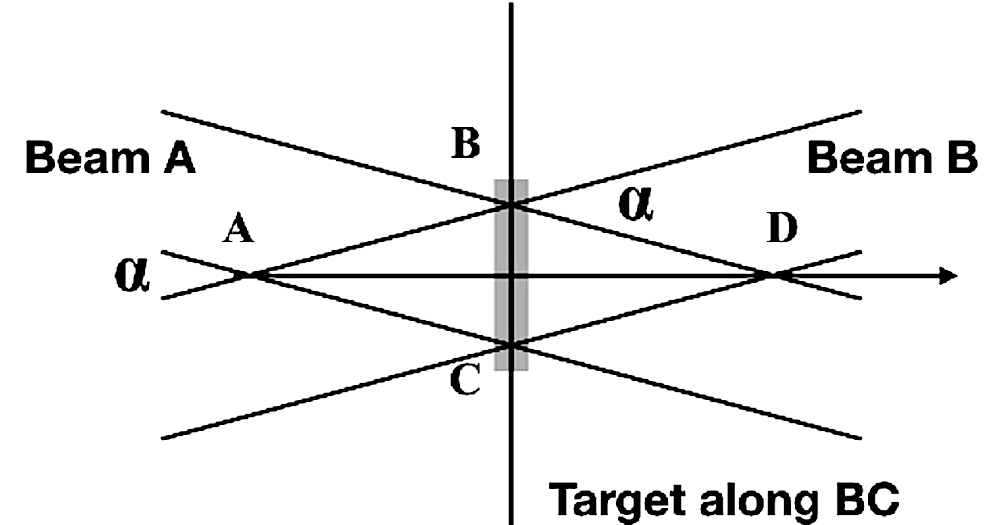
Figure A1. Schematic picture of the interaction (intersection) volume of two identical beams A and B of a radius R . The angle between beams is α = 5 · 10 − 4 rad [53] and | BC | (cid:39) 2 R . The bar interior of this volume shows a traditional arrangement of target, as discussed